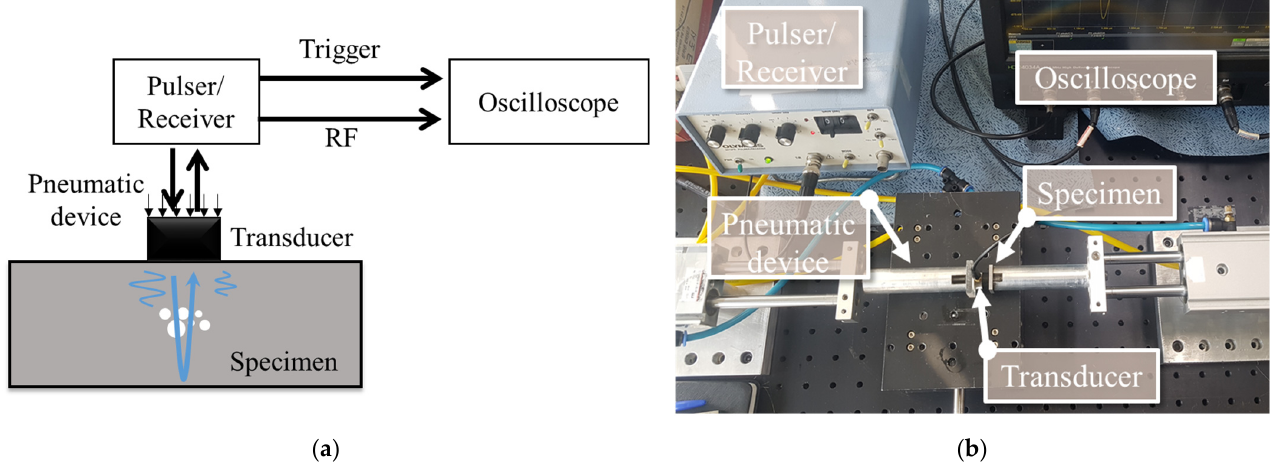
Figure 4. ( a ) Schematic diagram and ( b ) image of the experimental setup.